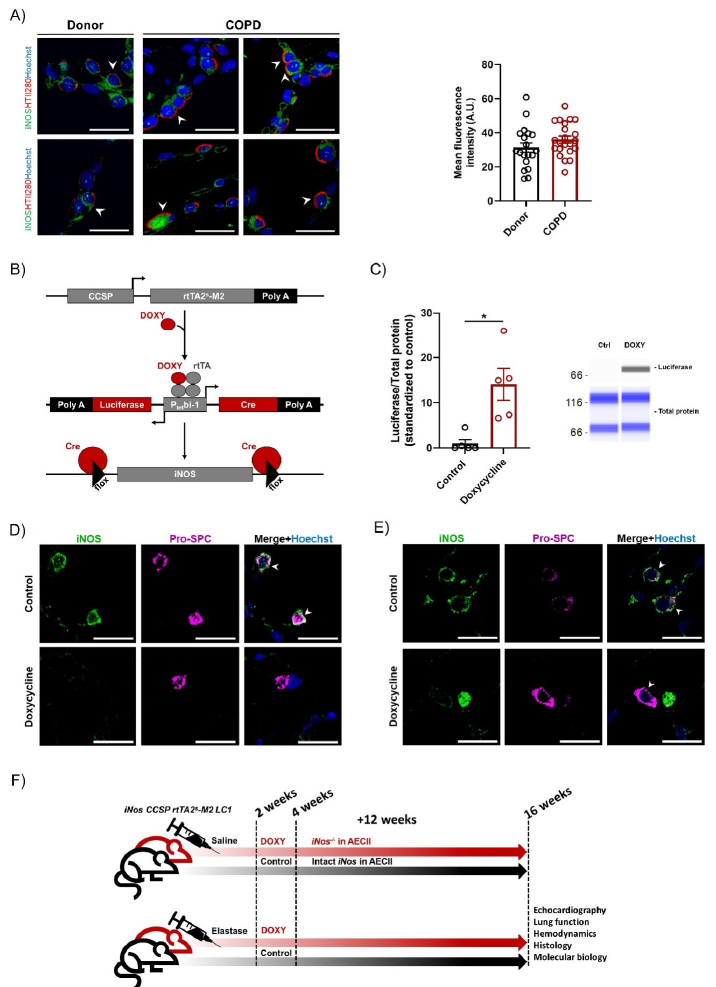
Figure 1. iNOS is successfully deleted in AECII using iNos CCSP rtTA2 s -M2 LC1 mouse line. ( A ) Representative images of human tissue sections from donor and COPD lungs, co-stained against iNOS (green) and AECII apical membrane protein HTII280 (red), and counter-stained with Hoechst. Fluorescence intensity of the iNOS staining in AECII (HTII280-positive cells) was quantified. Arrows indicate double-positive cells. Scale bar = 20 µm. For the signal intensity quantification, every point on the graph represents quantification of the mean fluorescence intensity in one AECII. No fewer than 4 images per group were quantified. ( B ) Schematic representation of the genetic constructs allowing for club-cell secretory protein (CCSP)-reverse tetracycline-dependent transactivator ( rtTA2 s -M2 )–mediated, doxycycline-controlled luciferase (Luc) and Cre expression and iNOS deletion in mice. ( C ) Automated Western-blot analysis ( n = 5) of luciferase expression in AECII isolated from mice fed with either normal (control, ctrl) or doxycycline-containing food. ( D , E ) Representative images of lung sections from control and AECII-specific iNOS knockout mice, immediately ( D ) and 12 weeks ( E ) after the termination of doxycycline feeding for cell type-specific iNOS knockout induction. The samples were co-stained against pro-SPC (magenta) and iNOS (green) and counterstained with Hoechst (blue). Scale bar = 20 µ m. Arrow: AECII (pro-SPC-positive) cells. ( F ) Schematic representation of experimental design used to assess the effect of iNOS expression in AECII on the regeneration of alveolar epithelium and the reversal of pulmonary hypertension in an elastase mouse model. DOXY: Doxycycline. A.U.: Arbitrary units. Graphs show mean ± SEM. * p < 0.05. An independent t -test was